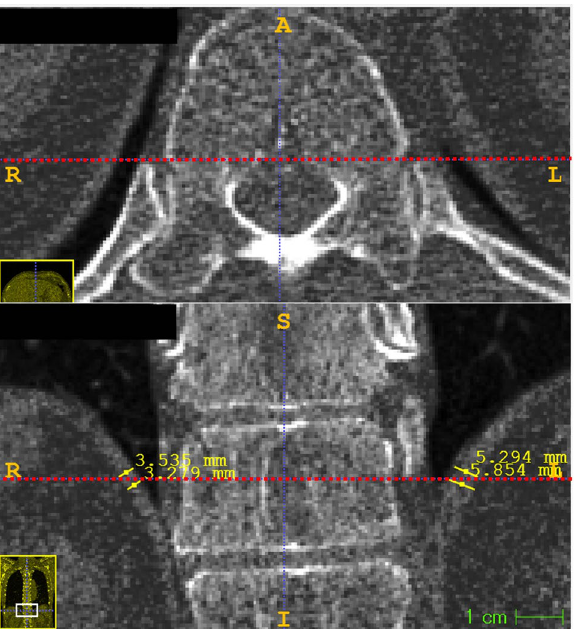
Figure 8. Diaphragm thickness measurement. A line was drawn through the anterior border of the spinal canal at T11 to L1 vertebral body level on the axial image (upper). Software automatically displayed intersection points of the line and diaphragm on the coronal image (lower). Diaphragm thickness was measured at the corresponding points two times on each side of the diaphragm and the mean value was